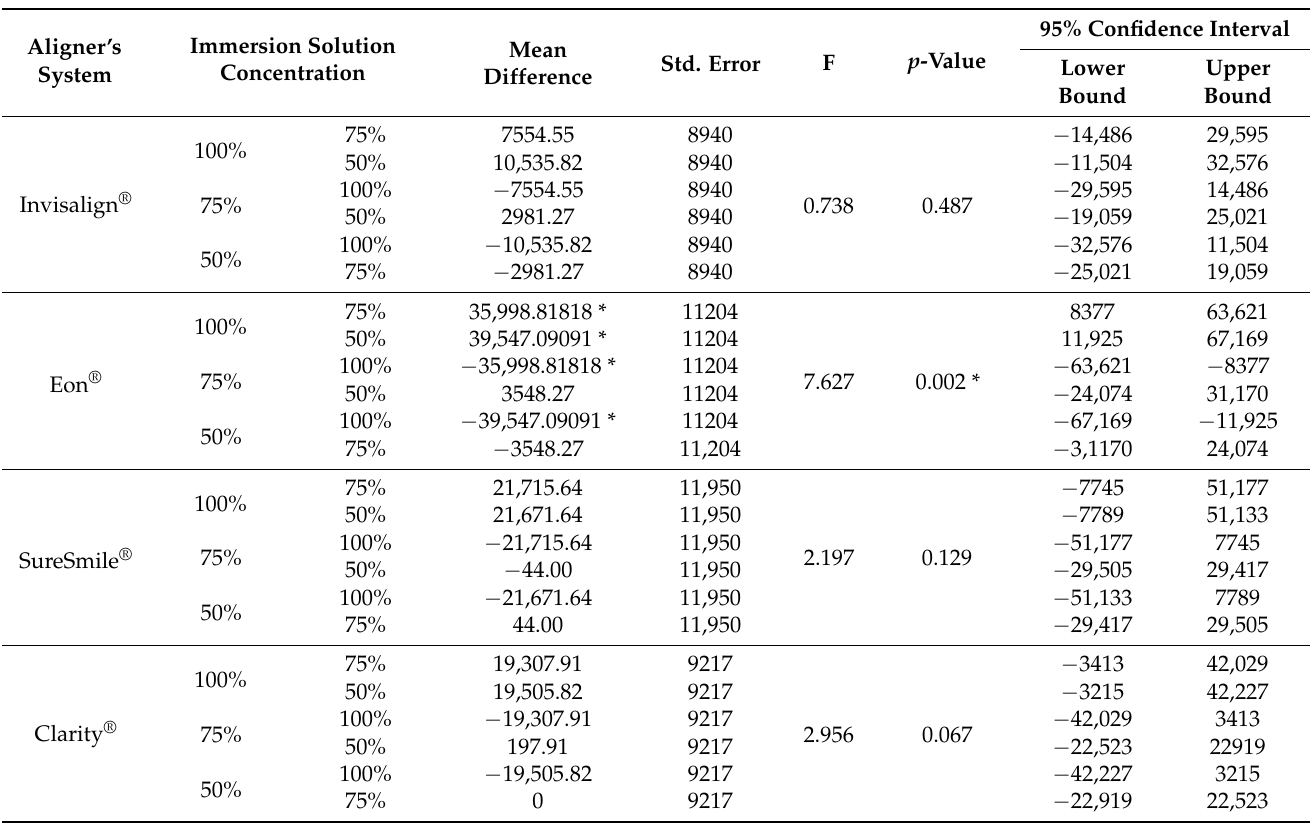
Table 3. Comparison between systems in relation to number of detected chemical compounds at variable immersion solution